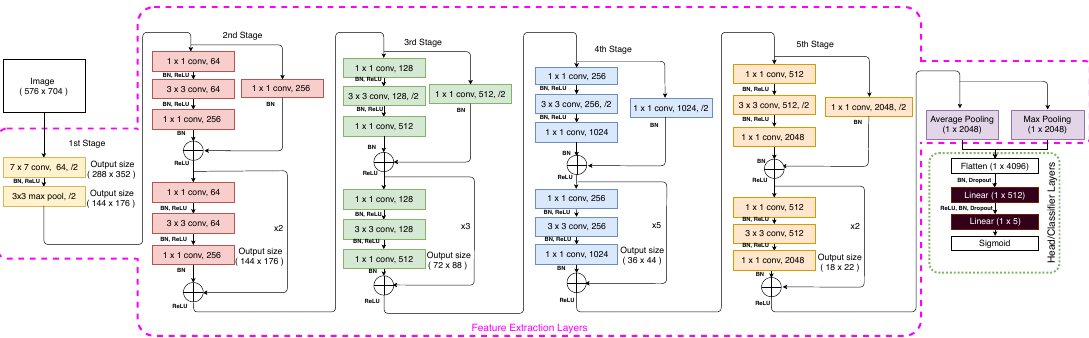
Figure 3. ResNet-50 architecture with modified